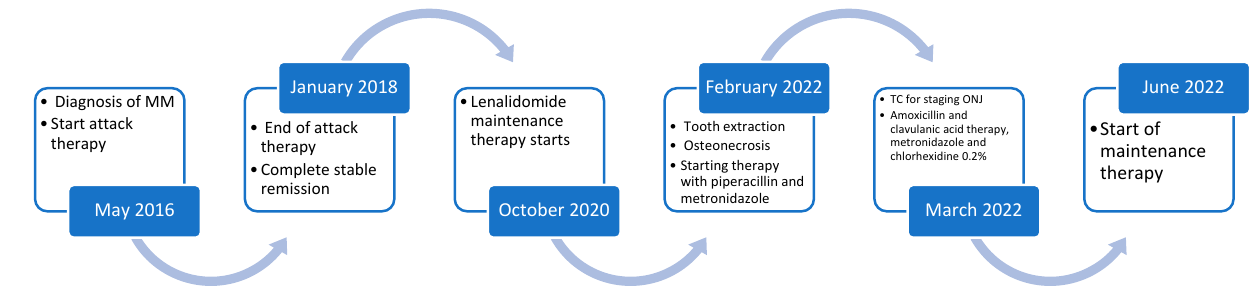
Figure 4. Patient’s medical history timeline .